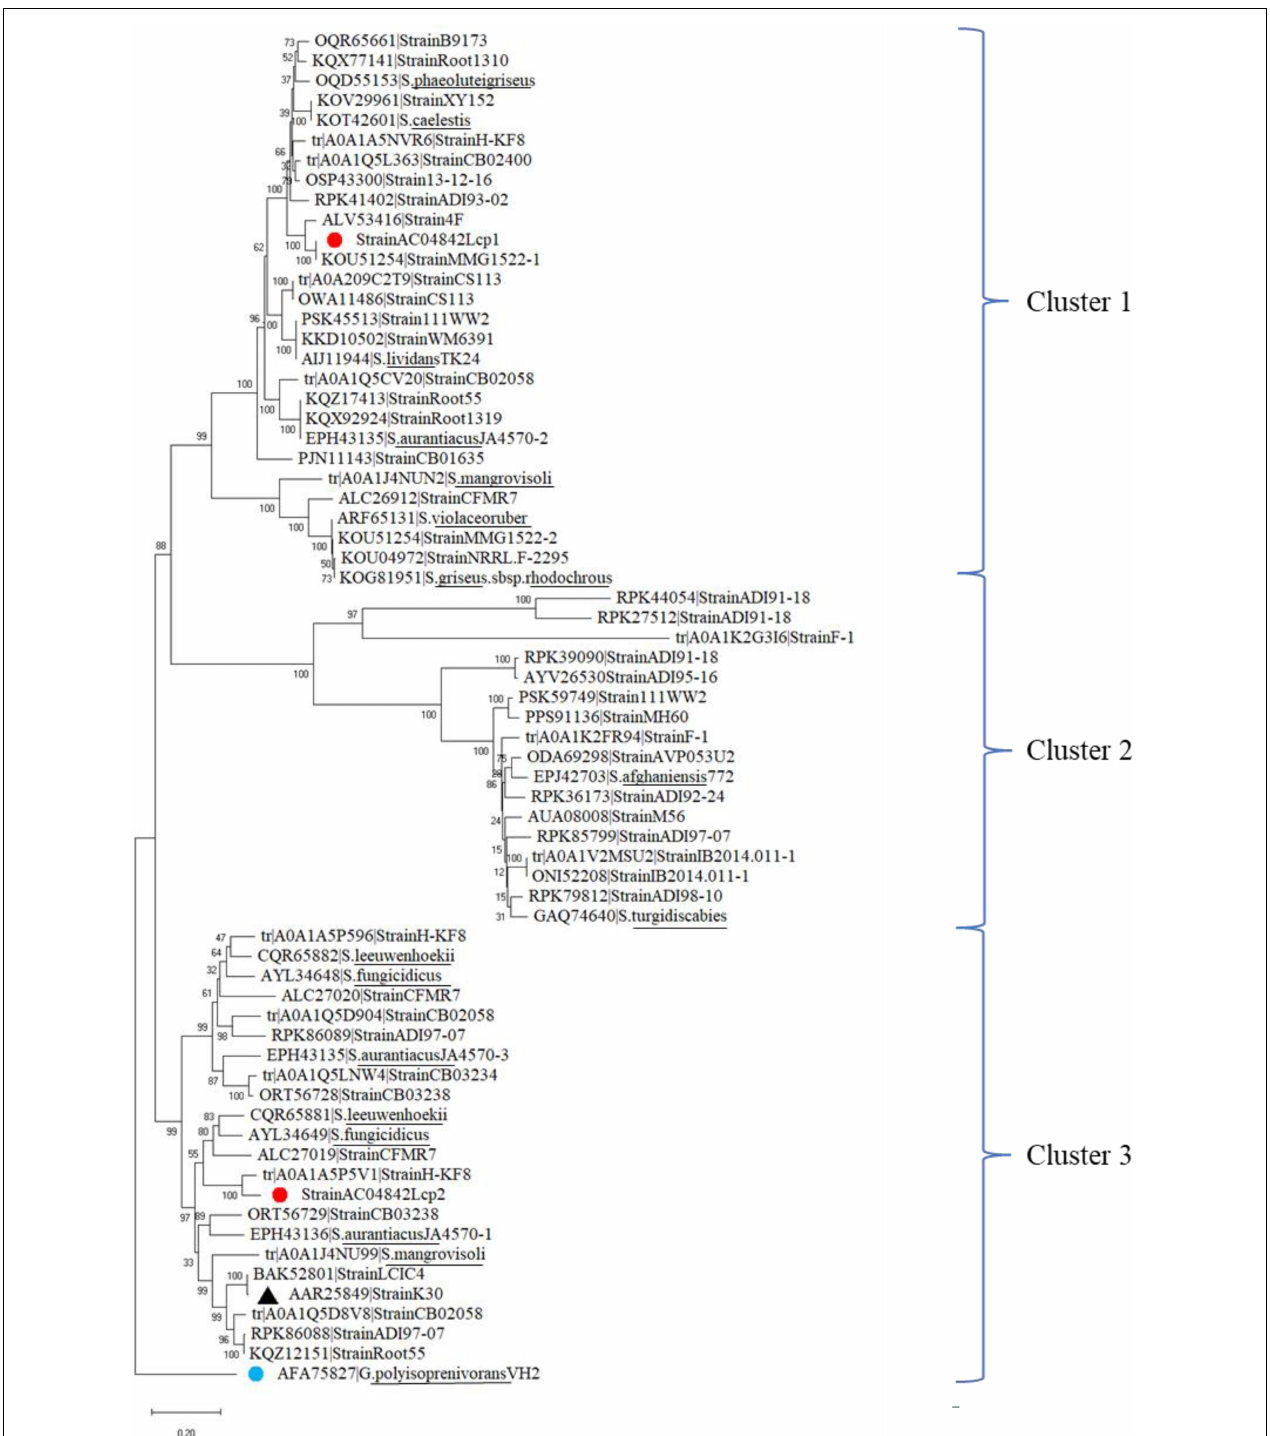
FIGURE 8 | Phylogenetic distribution of 65 lcp amino acids from 45 Streptomyces strains obtained from the GenBank, UniProt, and Streptomyces sp. AC04842 (red dot). The lcp1 amino acid from Gordonia polyisoprenivorans was used as an outgroup (blue dot). The tree was constructed using MEGA X. The bootstrap value was 1,000. The bar below the phylogenetic trees represents the scale of sequence